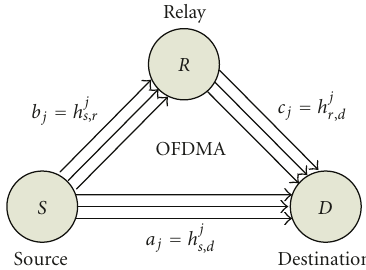
Figure 2: OFDMA-based cooperative relay transmission